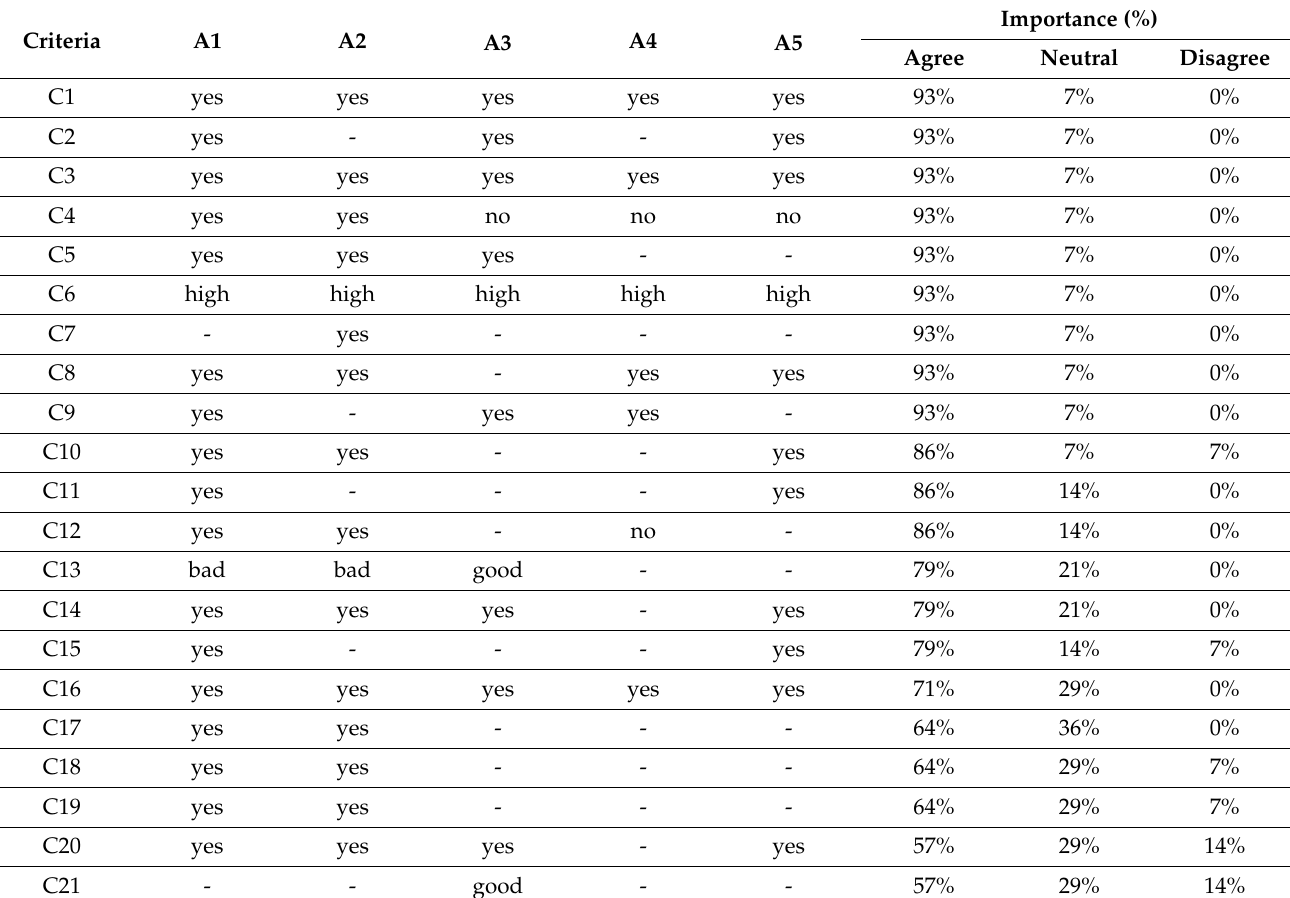
Table 2. Experts’ estimates and the importance of criteria for IoT platforms assessment (linguistic